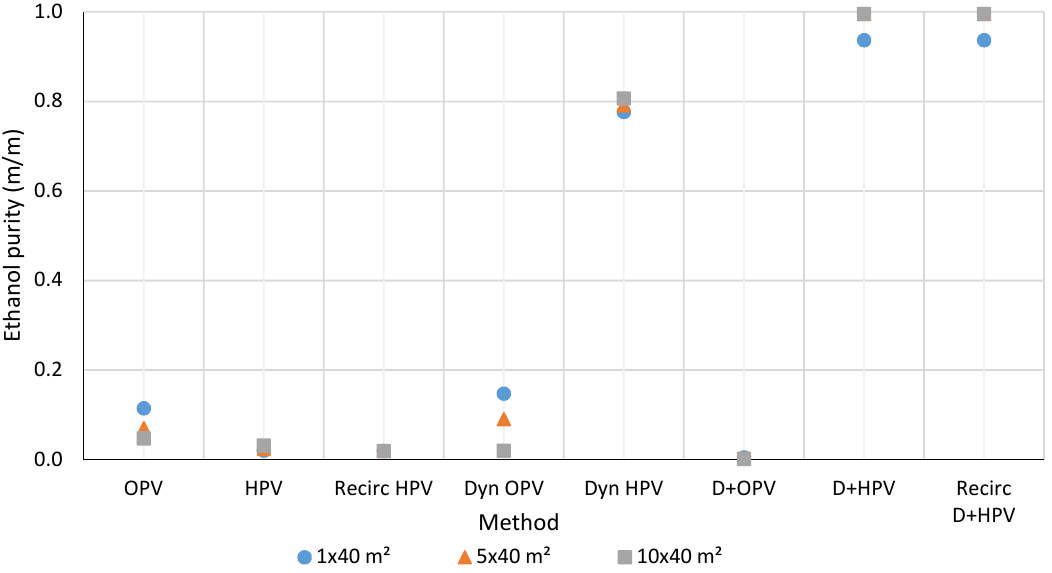
Figure 11. Comparison of the water purity of methanol-water separation methods.